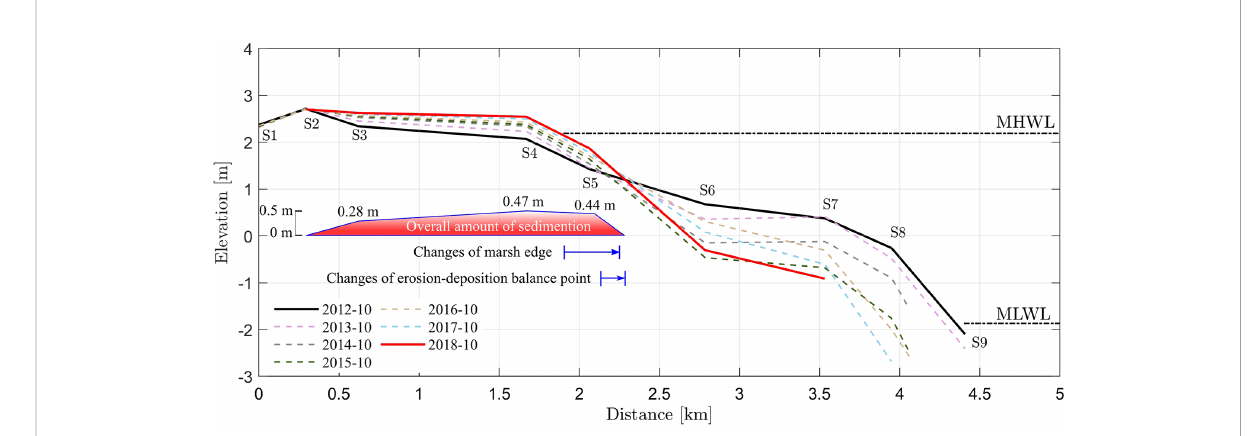
FIGURE 5 Variation of the cross-shore pro fi le from 2012 to 2018. The shade highlights the changes of the salt marsh edge from 2012 to 2018. The changes of marsh edge and the erosion-deposition balance point is highlighted with the blue